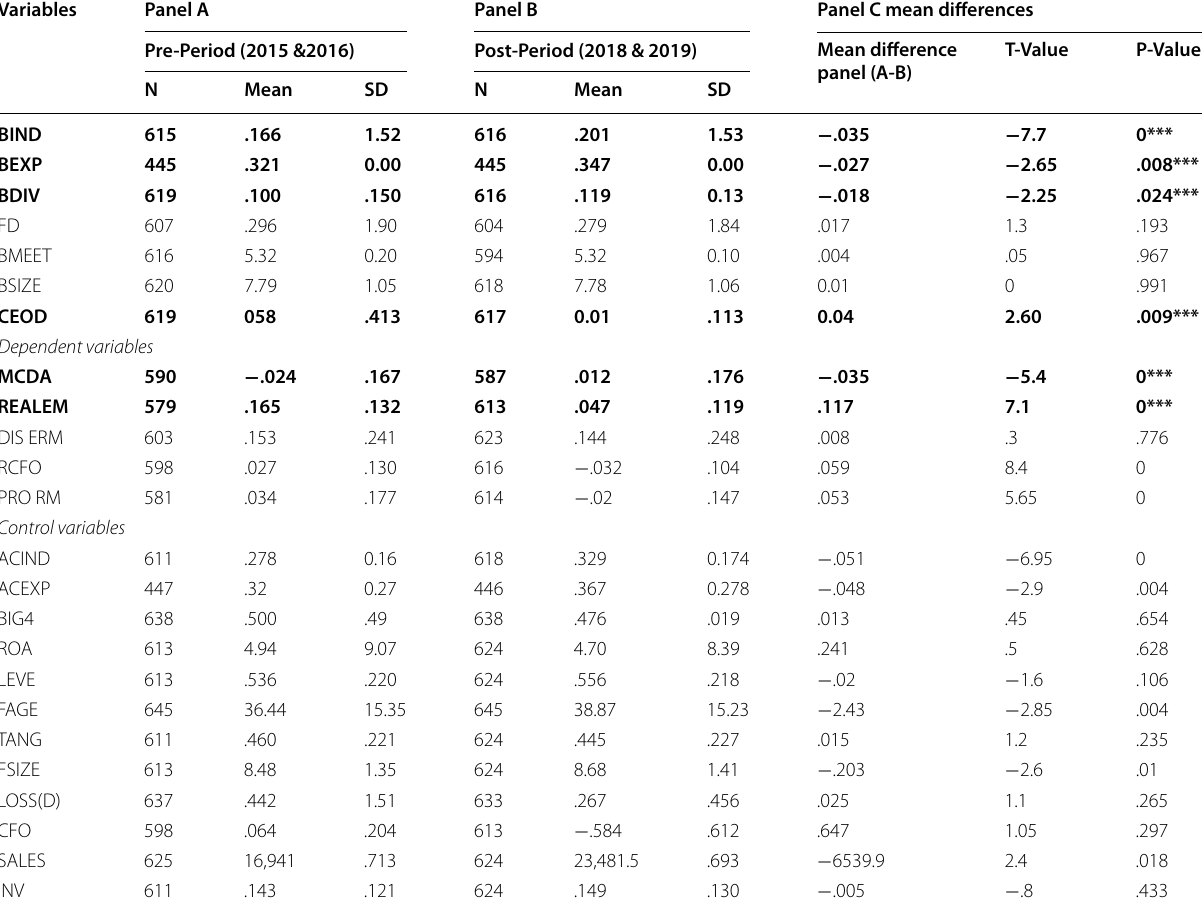
Table 6 T-Test for the differences in mean of pre- and post-period of CCG-2017 Variables Panel